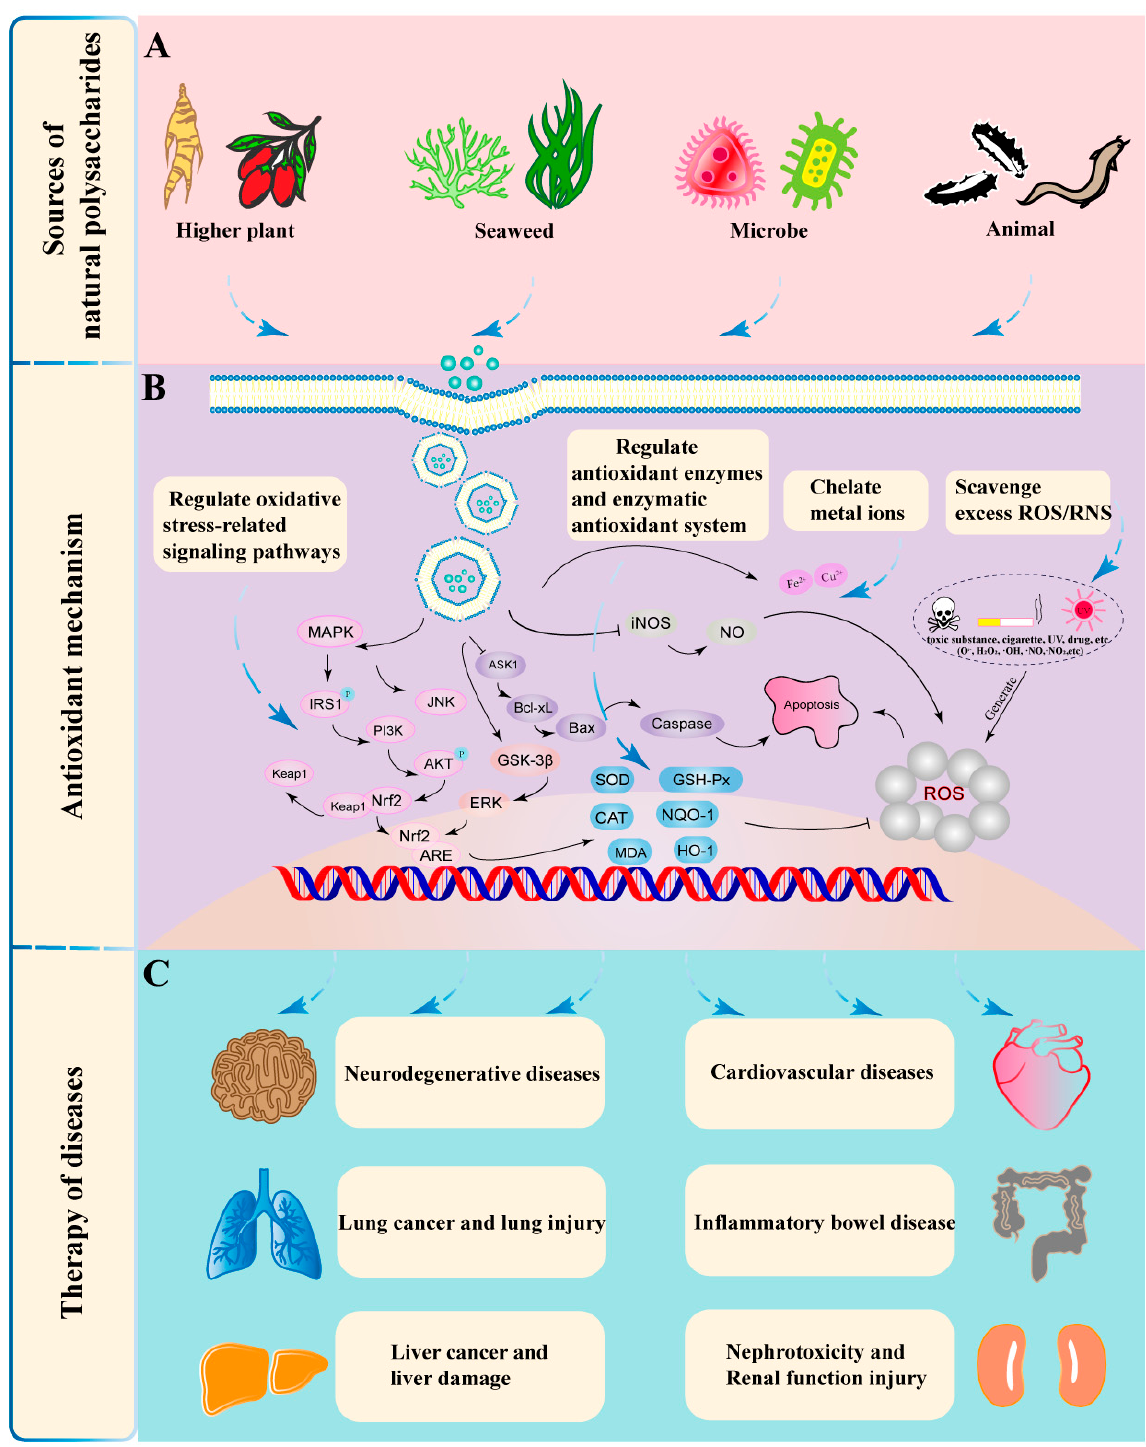
Figure 2. An overview of natural antioxidant polysaccharides. ( A ) The four types of polysaccharide sources; ( B ) the antioxidant mechanism of polysaccharides and their derivatives; ( C ) the therapeutic effects of natural polysaccharides on ROS-induced diseases.